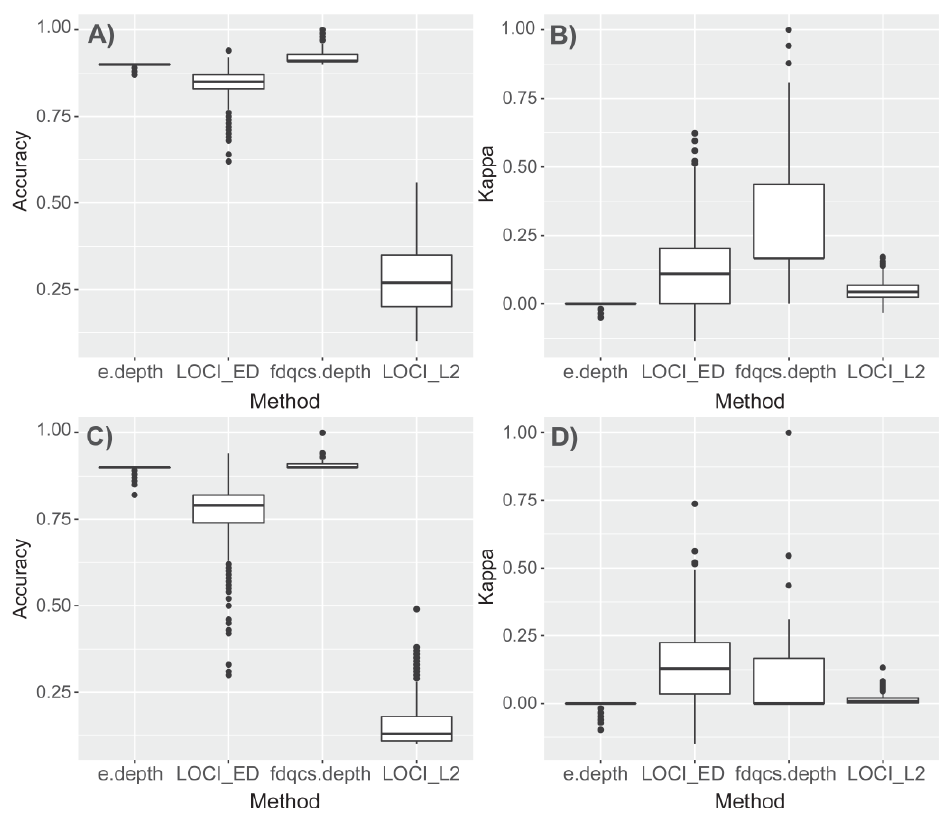
Figure 4. Accuracy and kappa classification performance indices corresponding to scenarios with anomalous curves in shape ( 𝜂 = 1 ). ( A ): Accuracy indices corresponding to the four model alterna- tives in the scenario defined by independence between curves. ( B ): Kappa indices corresponding to the four model alternatives in the scenario defined by independence between curves. ( C ): Accuracy indices corresponding to the four model alternatives in the scenario defined by dependence between curves ( 𝜌 = 0.7 ). ( D ): Kappa indices corresponding to the four model alternatives in the scenario defined by dependence between curves ( 𝜌 = 0.7 ).